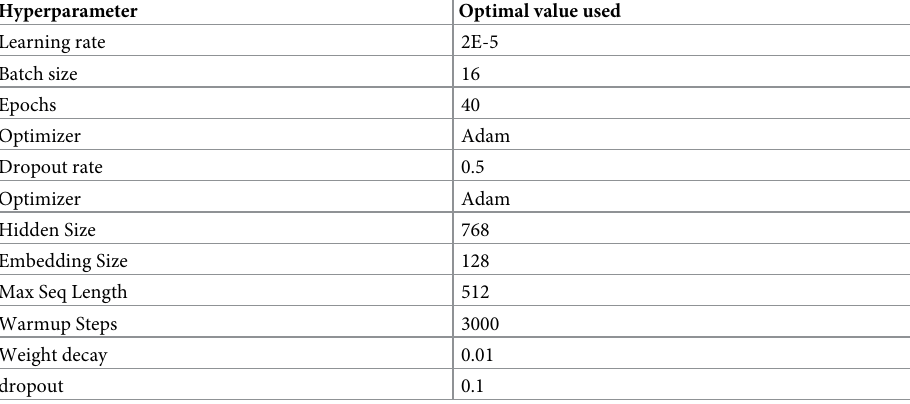
Table 3. Hyperparameters